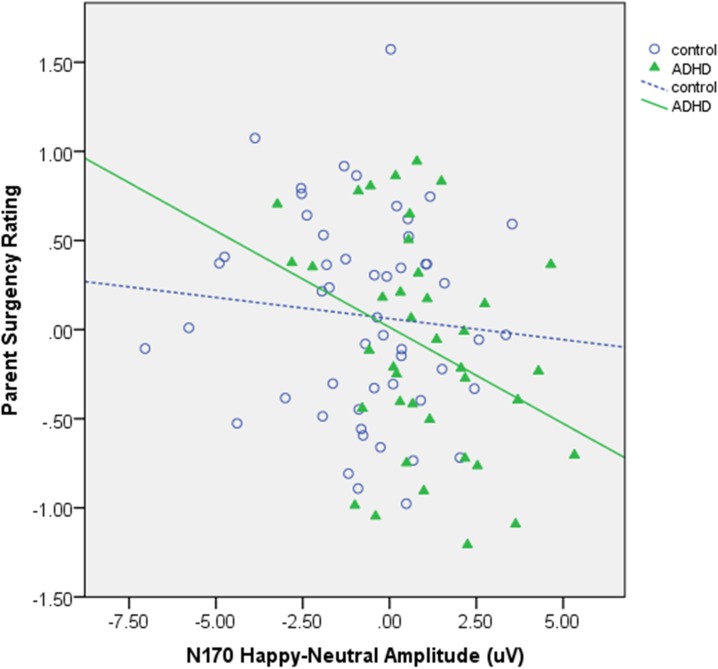
Scatterplots of significant regressions between N170 happy-neutral difference wave and surgency.Unstandardized residuals of temperament ratings are represented.